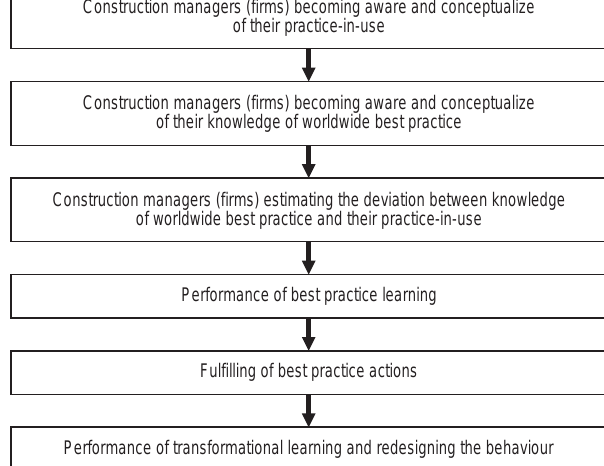
Fig. 2. Performance of transformational learning